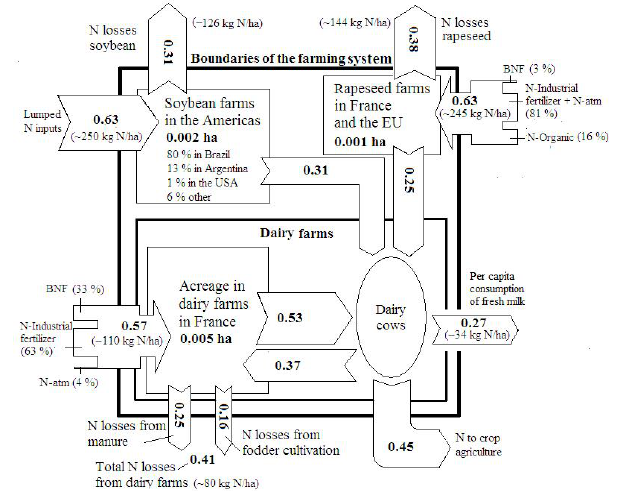
Fig. 4. The components of the N food-print